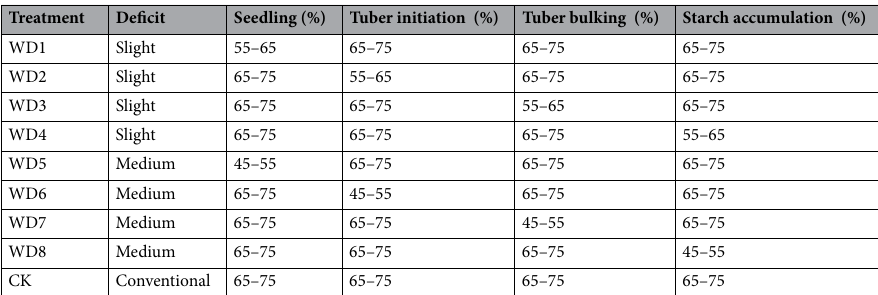
Table 7. Soil water content (% field capacity) in conventional irrigation and regulated deficit drip irrigation treatments during potato growth. The treatments were two levels of water deficit that occurred in each of four growth stages. The data in the table show the percentage of soil mass water content in field water holdup under different experimental treatments. "Slight" means that the soil water deficit level was controlled at a “Mild” level with soil water content maintained at 55–65% of field capacity during certain plant growth stage in the treatment while it was maintained at 65–75% of field capacity at the other plant growth stages in the same treatment. Similarly, "Medium" means that the soil water deficit level was controlled at a “Moderate” level with soil water content maintained at 45–55% of field capacity during certain plant growth stages in the treatment while it was maintained at 65–75% of field capacity at the other plant growth stages in the same